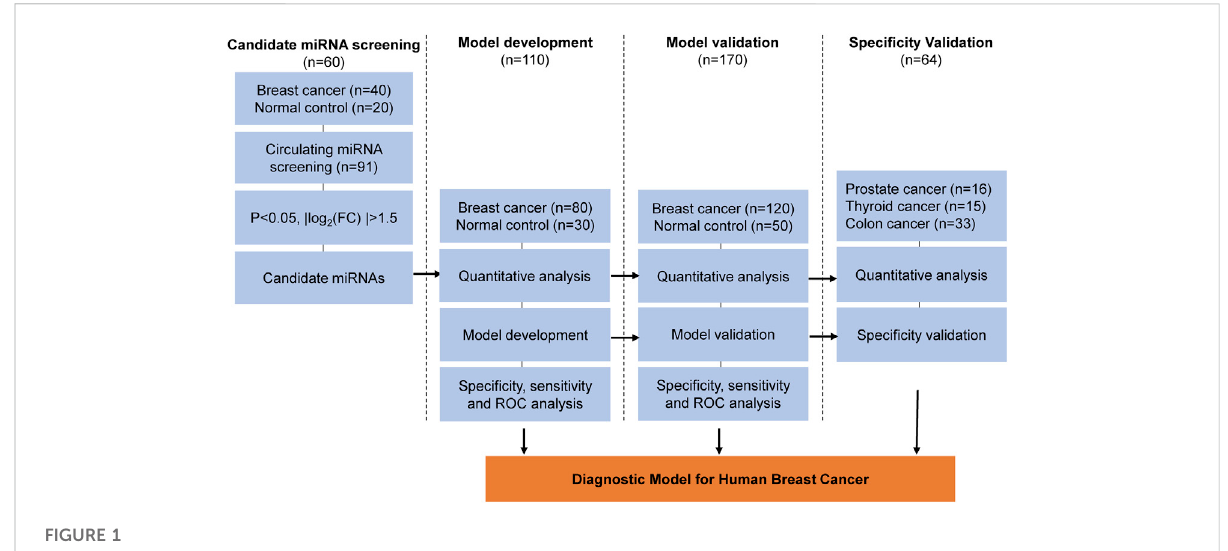
FIGURE 1 Overview of the study